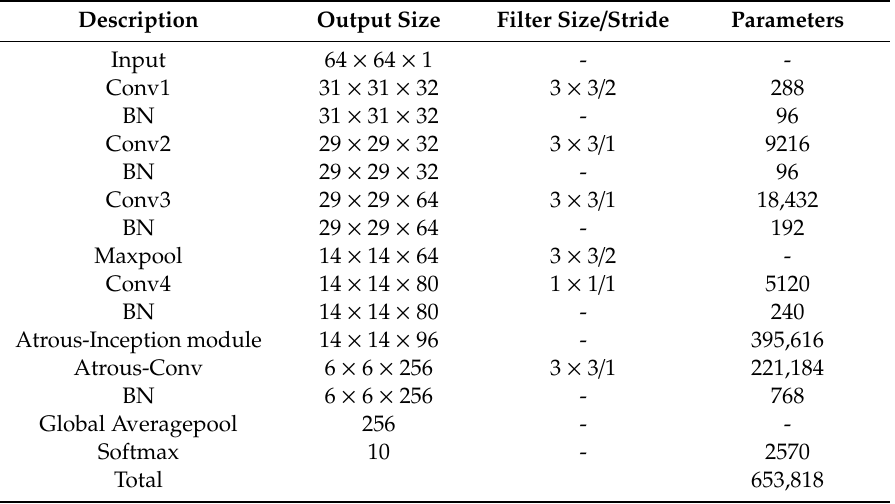
Figure 1. The structure of the proposed network. Table 1. The proposed TAI-SARNET parameters setting.